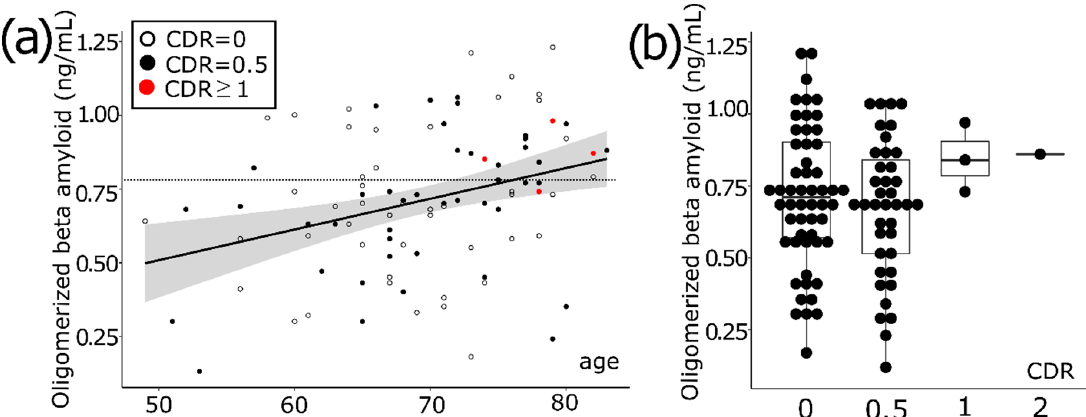
Figure 1. The distribution of plasma concentration of oligomerized beta amyloid (OA β ). ( a ) OA β concentration increases with aging. The dotted line indicates a cut-off value of 0.78. CDR indicates the clinical dementia rating. ( b ) Most participants have a clinical dementia rating (CDR) of 0 or a CDR of 0.5. OA β concentration was similar both in the CDR 0 and CDR 0.5 group.